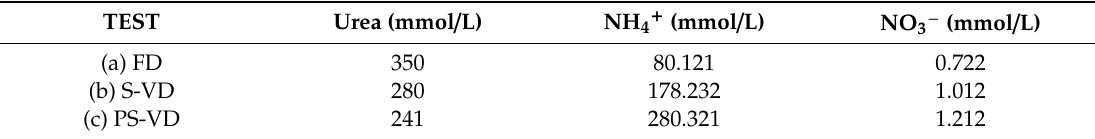
nitrogen-containing aqueous product of urea photodegradation in the synthetic urine was ammonia. Table3. Urea(mmol / L),NH 4 + (mmol / L),andNO 3 − (mmol / L)concentrationsafter240minofirradiation, using light modulations on synthetic urine with (a) FD LED dimming, (b) S-VD, and (c) PS-VD LED dimming modulations; initial urea concentration: 25 g /